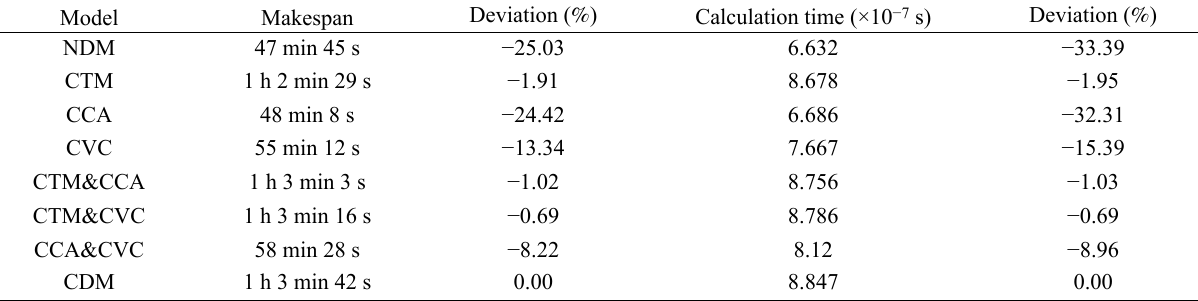
Table 5 Statistical table of the makespans.